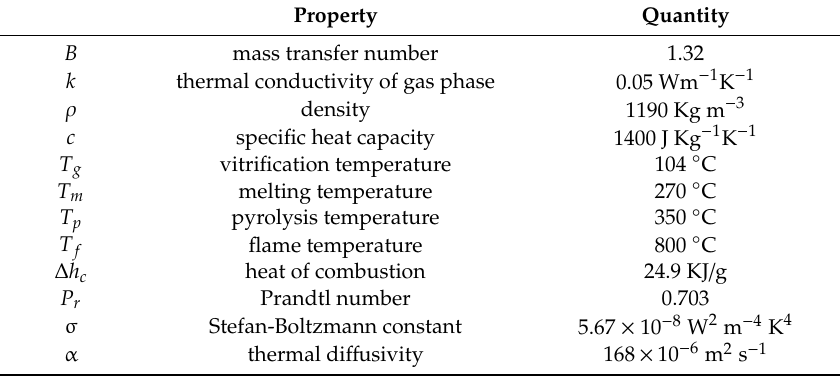
Figure 1. Experimental system. Table 2. Parameters of PMMA physical characteristics.